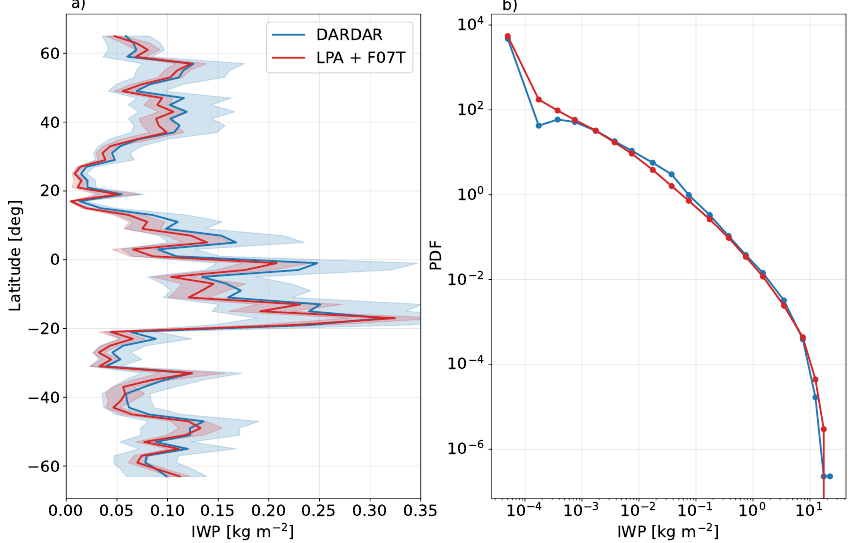
Figure 8. A comparison of the ( a ) the zonal means and ( b ) PDF of the IWPs from the DARDAR product and the IWP obtained by inverting CloudSat reflectivities. The blue shaded region corresponds to the ± 40% uncertainty in the DARDAR IWP (see text), while the red shaded region represents the one standard deviation around the mean of the simulations, which was calculated by random sampling with replacement (bootstrapping). The particle model for simulations (red) was large plate aggregate (LPA) + F07T. The data were from January